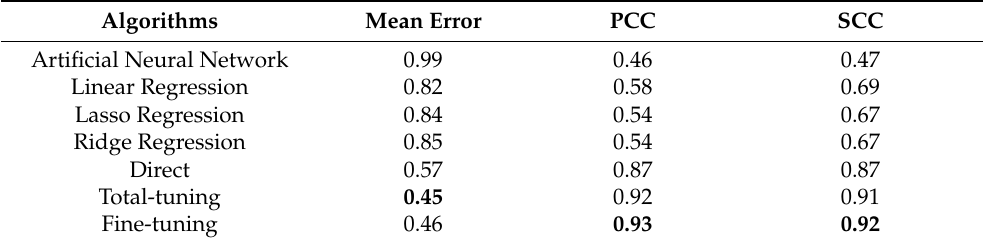
Table 6. Evaluation of algorithms’ prediction results with true results from entire dataset. Bold indicates the best score in each case. The range of MAE is [0,10].